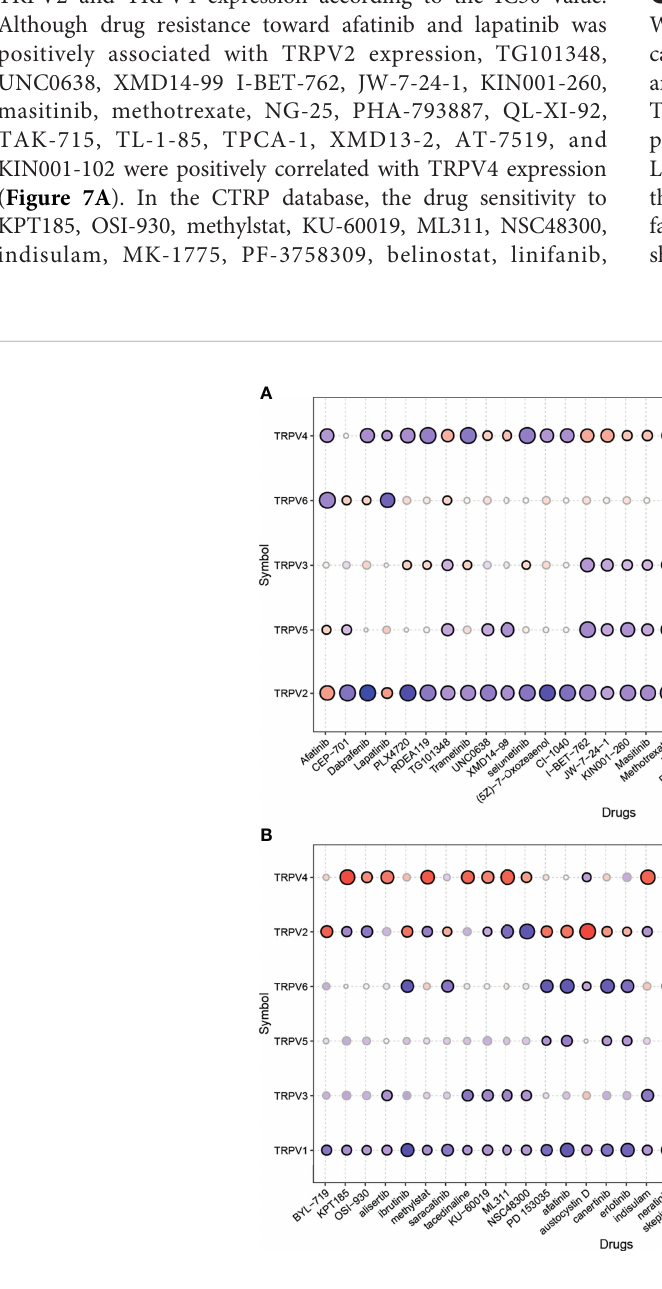
FIGURE 7 | Drug sensitivity analysis of TRPV channel-related genes. (A) The gene set drug sensitivity analysis from Genomics of Drug Sensitivity in Cancer (GDSC) IC50 drug data. (B) The gene set drug sensitivity analysis from Cancer Therapeutics Response Portal (CTRP) IC50 drug data. The Pearson ’ s correlation indicates the correlation between gene expression and drugs sensitivity. Blue bubbles represented negative correlations, and red bubbles represented positive correlations; the deeper the color, the higher the correlation. The bubble size was positively correlated with the FDR signi fi cance. The black outline indicates an FDR < 0.05. Only the top 30 ranked drugs were